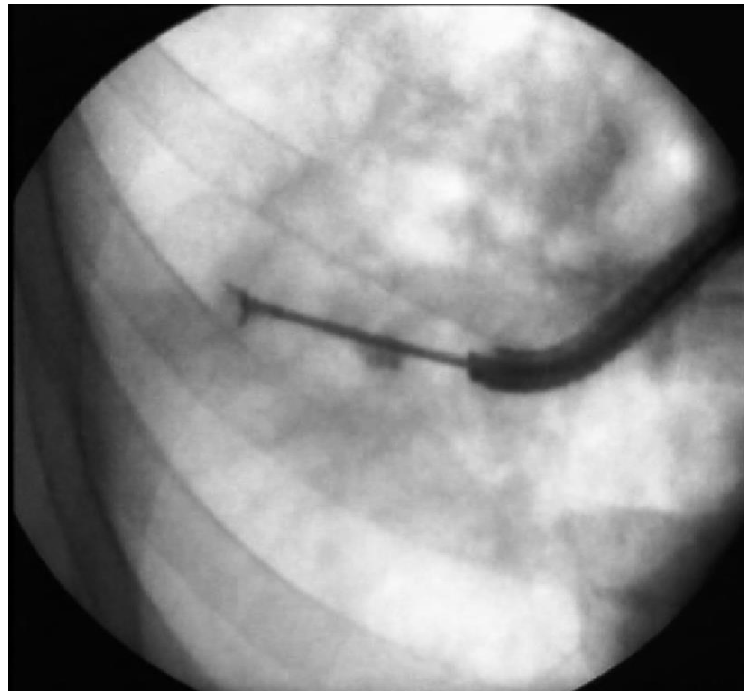
Figure 1. Fluoroscopy-guided bronchoscopic lung biopsy.